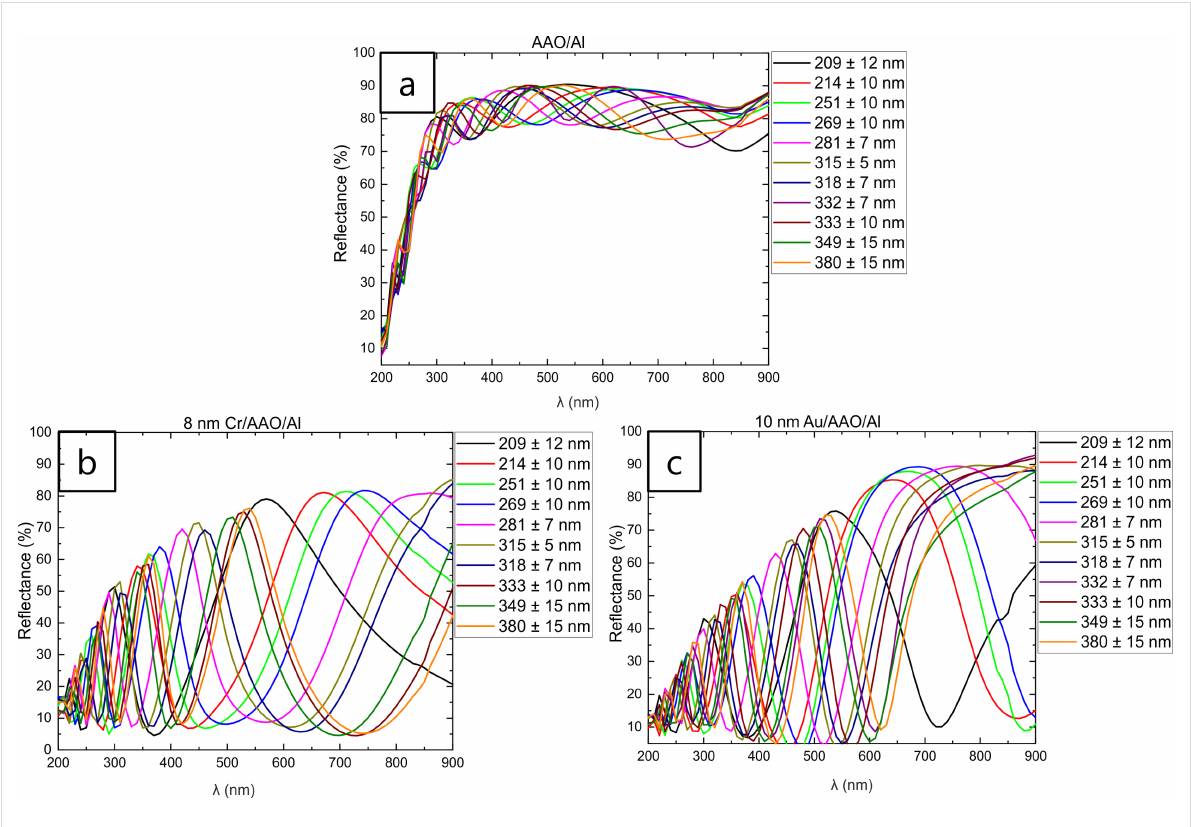
Figure 2: (a) UV–vis reflectance spectra of AAO–Al films, (b) UV–vis reflectance spectra of 8 nm Cr–AAO–Al films, and (c) UV–vis reflectance spec- tra of 10 nm Au-AAO-Al films with different thickness.